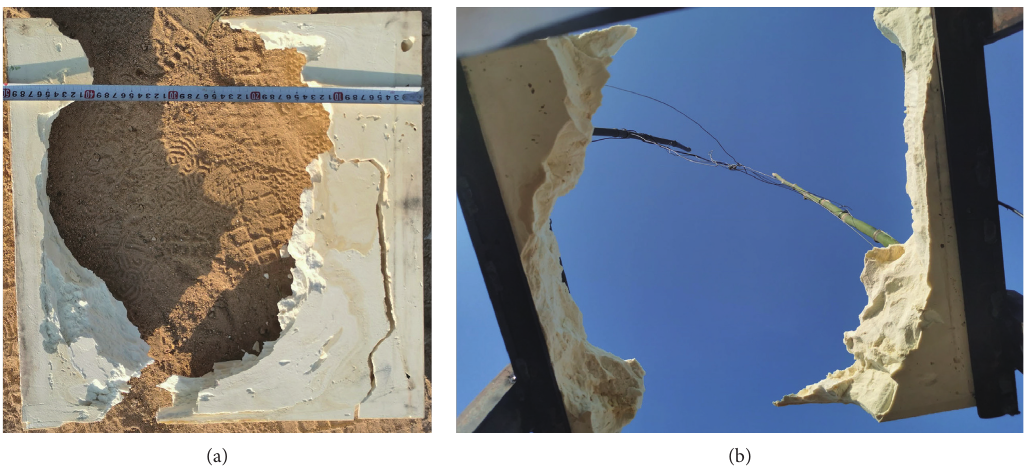
Figure 14: Test results of polymer slab B3 under 30g explosive. (a) Top surface. (b) Bottom